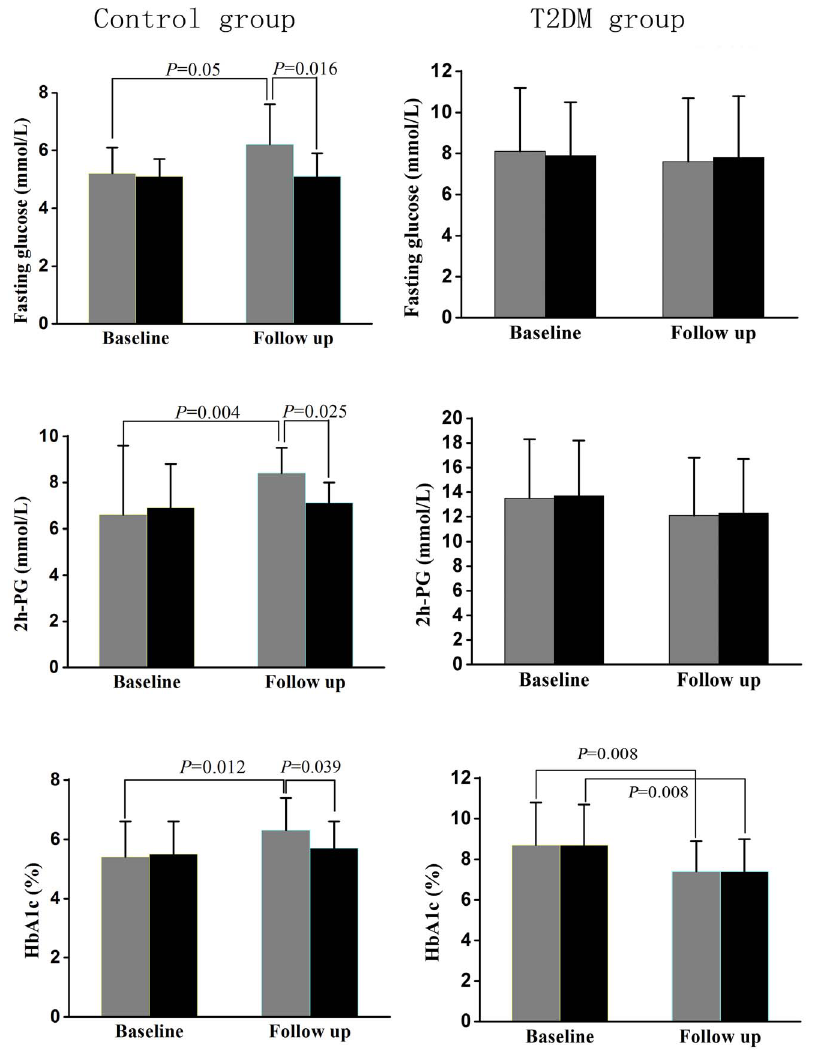
Figure 2. Glucose levels in groups with low and high serum vaspin concentrations. Gray and black bars represent diabetic patients with low and high vaspin levels, respectively. Fasting plasma glucose (FPG), 2-hour postprandial plasma glucose (2h-PG) and glycosylated haemoglobin A1c (HbA1c) were compared between those at baseline and follow-up in control and T2DM groups. Covariance analysis was used to analyze the differences between sub-groups.